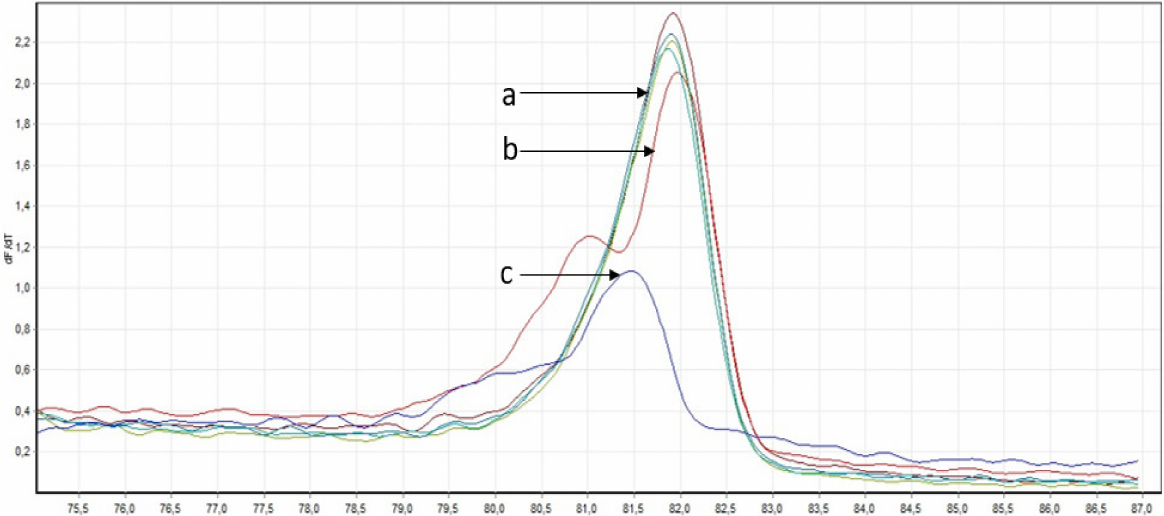
Figure 6. Derivatives of melting curves of amplicons obtained during PCR of a section of the CDH1 gene. ( a ) DNA samples without changes in the nucleotide sequence; ( b ) DNA sample with difference in melting point; ( c ) DNA sample with c.1320+1G>A (positive control). The patient was a 72-year-old woman with an established diagnosis of gastric cancer.